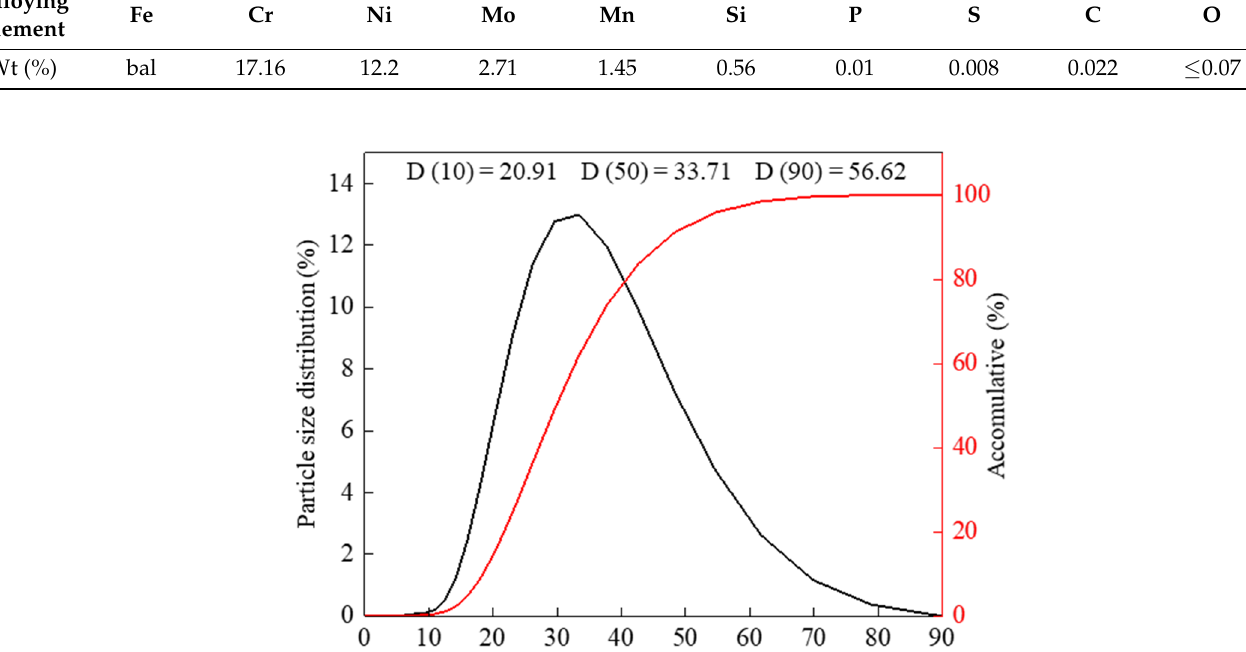
Table 1. Chemical composition of 316L.